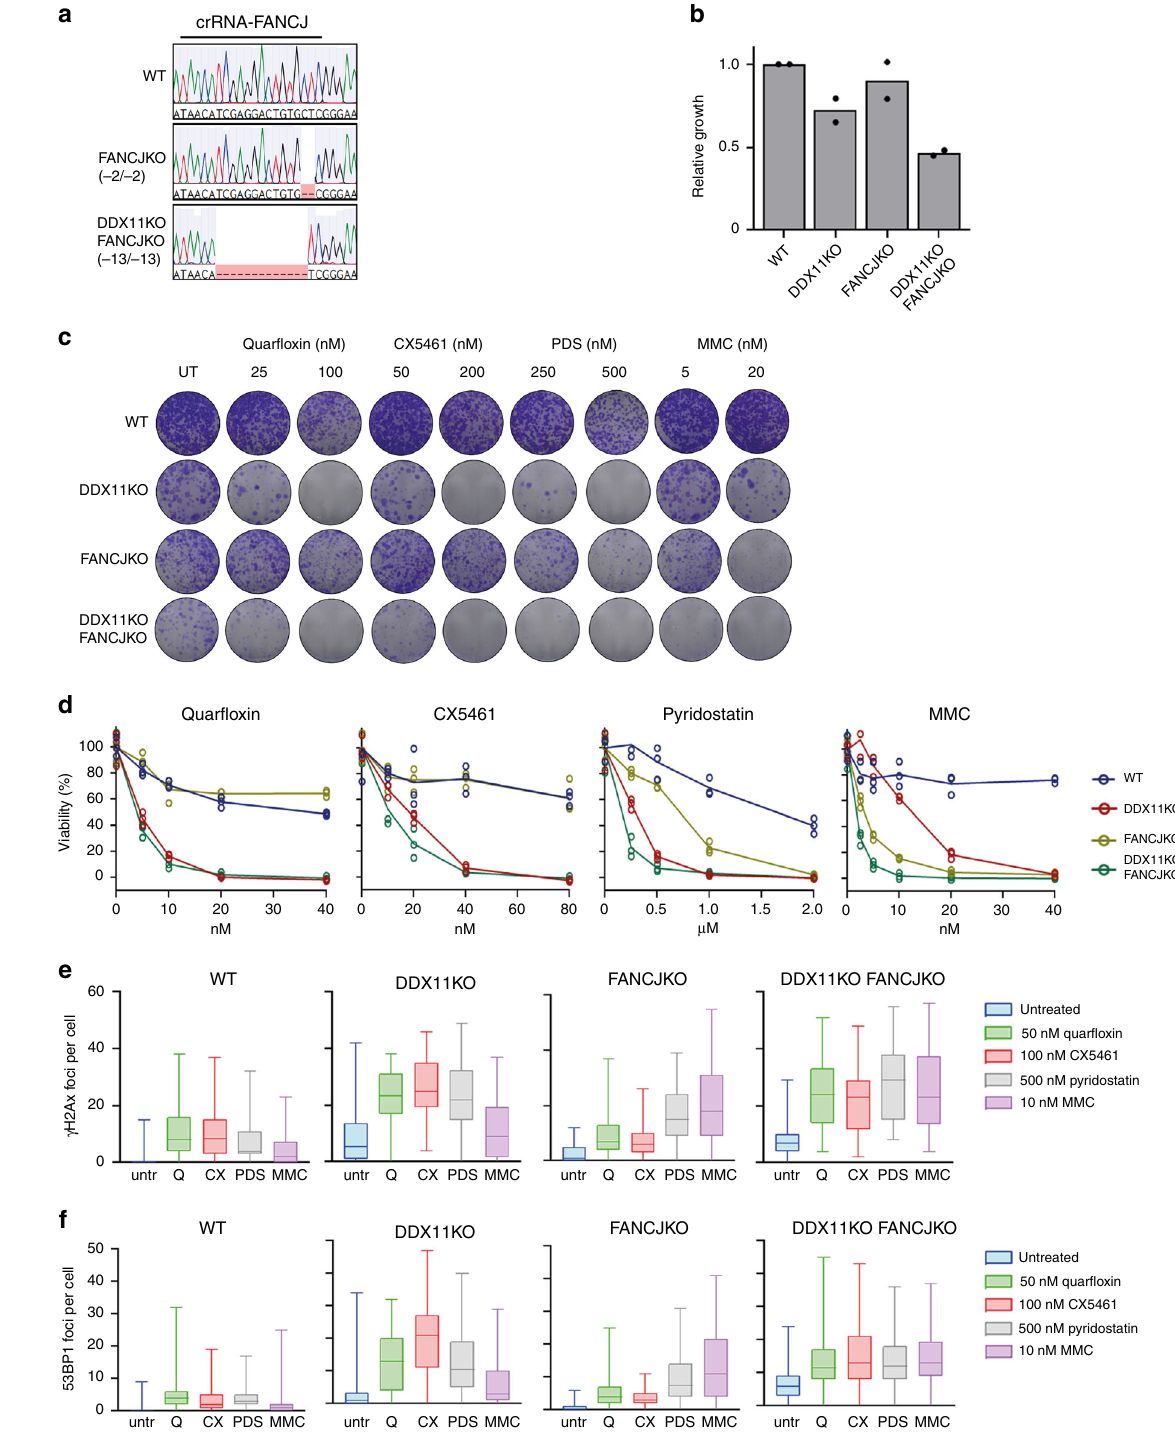
Fig. 7 Distinct functions of FANCJ and DDX11 in response to G4-stabilization. a Alignment of sequences of FANCJKO and DDX11KO-FANCJKO at the crFANCJ target site. b Cell growth relative to RPE1-TP53KO cells, as assessed by counting three days after seeding. Bars represent mean of two biological replicates. c Clonogenic survival assay was performed in cells treated as indicated for 24 h, and subsequently cultured for nine days. Representative images from two separate experiments are shown. d Cell titer blue assessed viability following fi ve days of the indicated treatments. Lines indicate the mean of three technical replicates. e , f Counts of γ H2AX ( e ) and TP53BP1 ( f ) foci per cell after 24 h treatments (n = 50 cells for two separate experiments). Boxes extend from the 25th to the 75th percentile, whiskers from the smallest to the largest value, lines indicate the